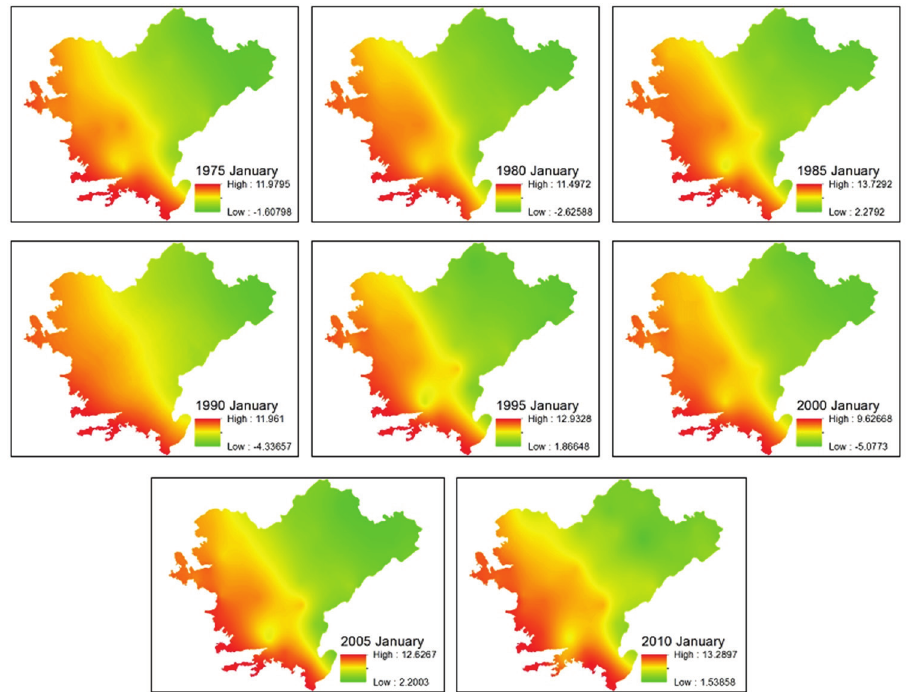
Figure 5 - The Ordinary Kriging interpolation results of the temperature data for the month of January (For the years of 1975, 1980, 1985, 1990, 1995, 2000, 2005, and